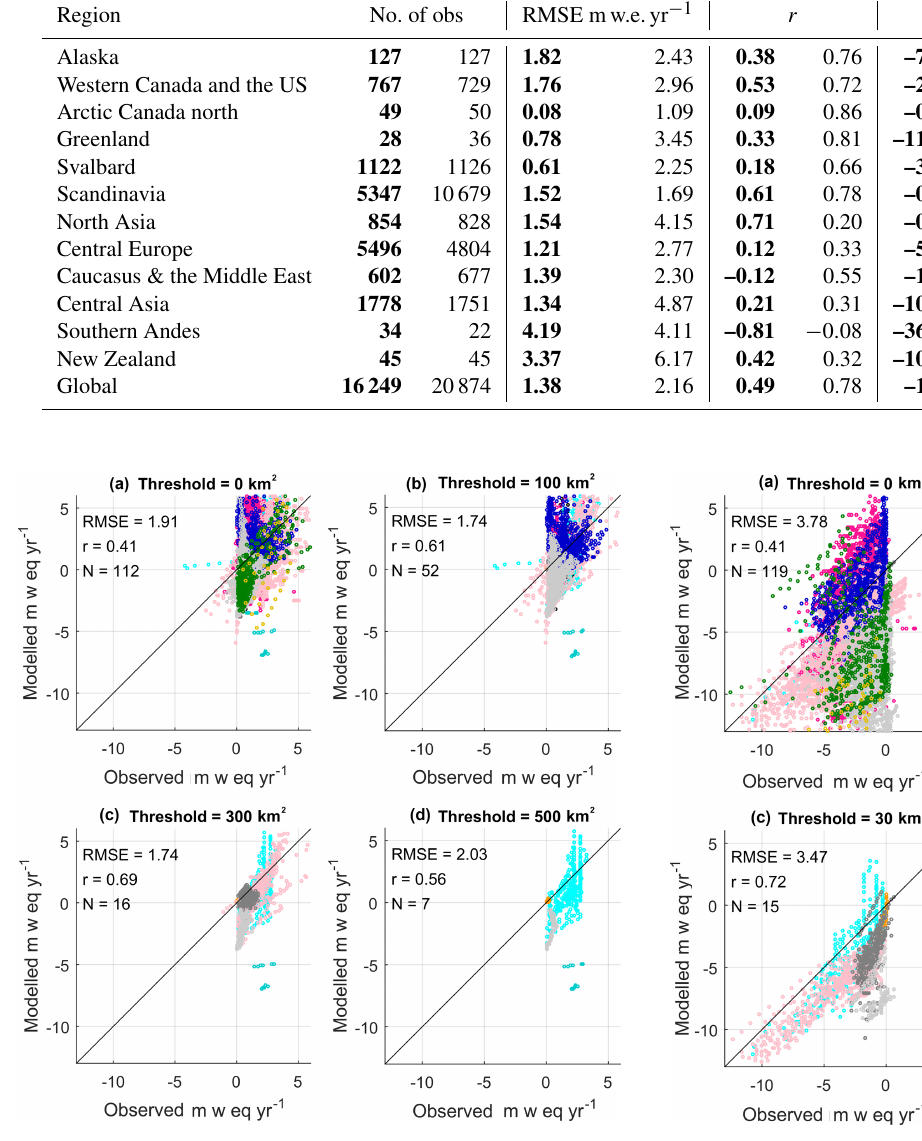
Figure 5. Simulated and observed elevation-dependent winter mass balance when grid boxes with a glacier area of less than 100, 300, and 500km 2 are excluded. The colour identifies the RGI6 regions shown in Fig. 2. The RMSE, correlation coefficient, and number of glaciers are listed.